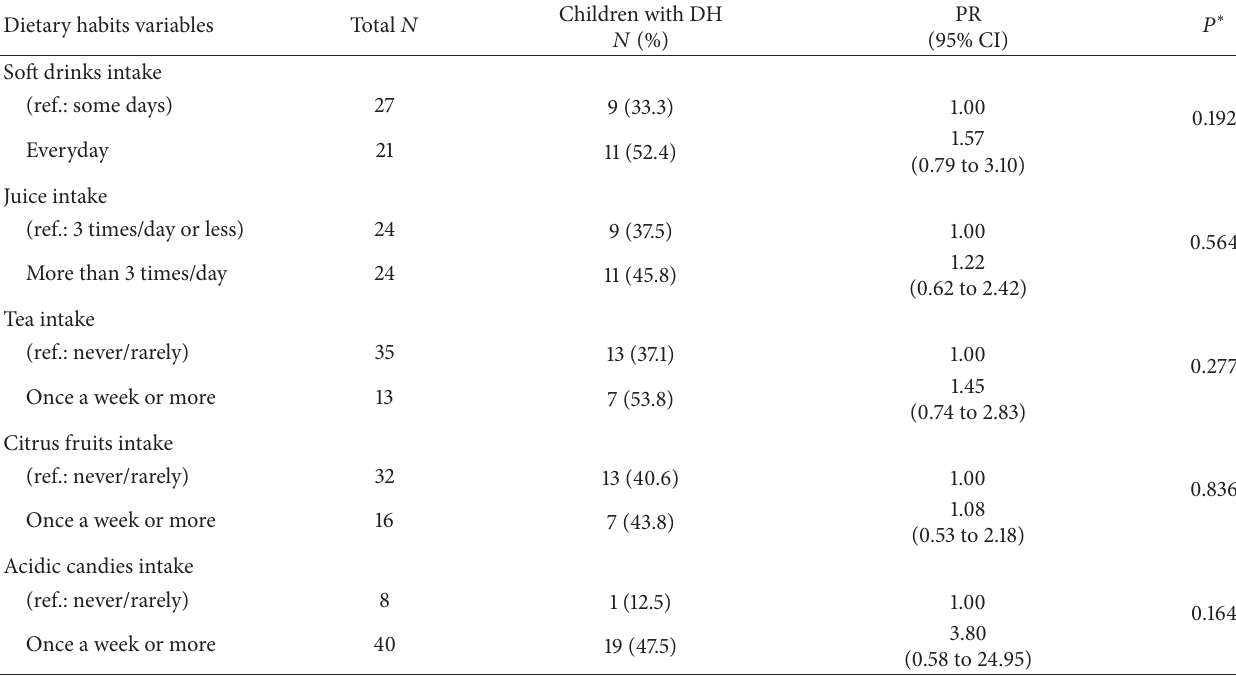
Table 2: Univariate Poisson regression analysis of the association between children’s dietary habits and presence of dental hypersensitivity. Dietary habits variables